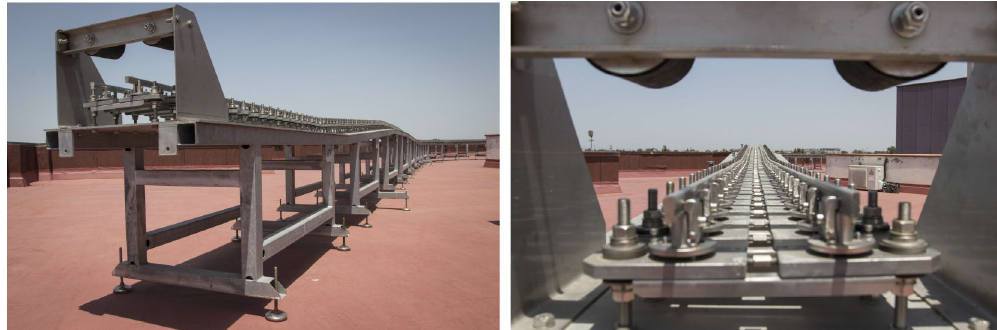
Figure 13. Structure with ascending and descending slopes (left) and buffer stops at the end of the track (right). Photographer: Ludivine Mimar.